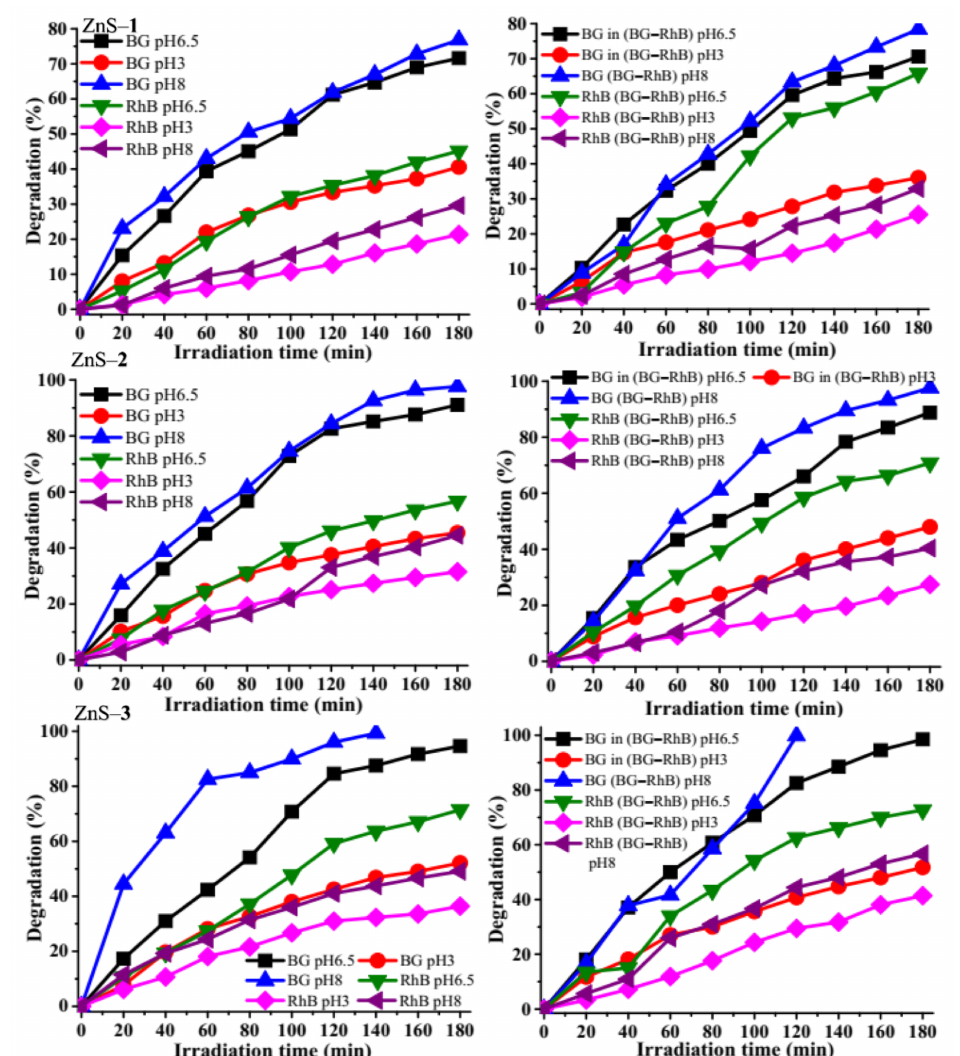
Figure 9. Effect of pH on brilliant green (BG), rhodamine B (RhB), and binary dyes over ZnS quantum